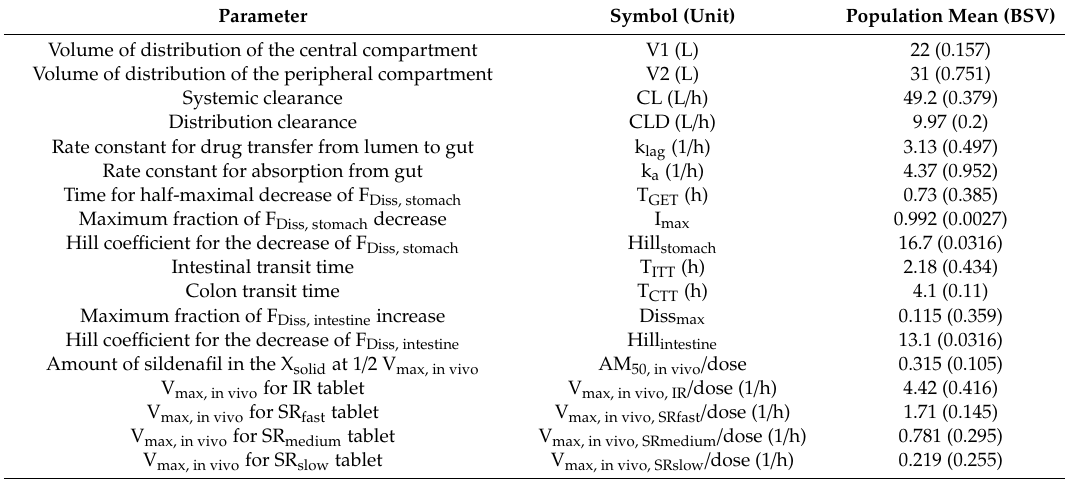
Table 4. Population pharmacokinetic parameter estimates of